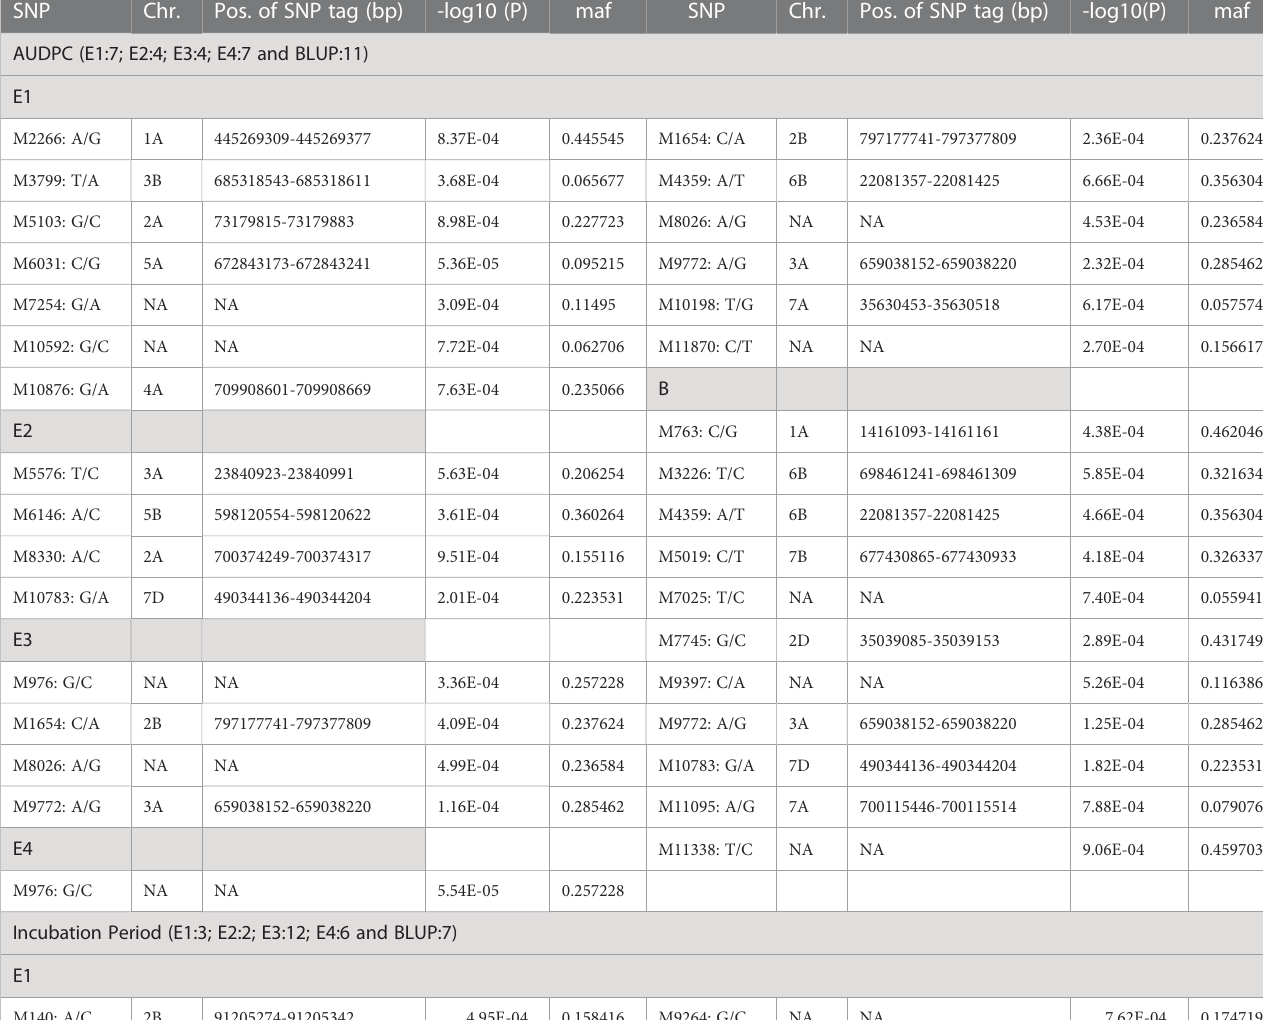
TABLE 2 A Summary of MTAs for each trait (one MTA in bold was detected by all the fi ve models; the remaining MTAs were detected by four models except SUPER; NA=not available). SNP Chr. Pos. of SNP tag (bp) -log10 (P) maf SNP Chr. Pos. of SNP tag (bp) -log10(P)